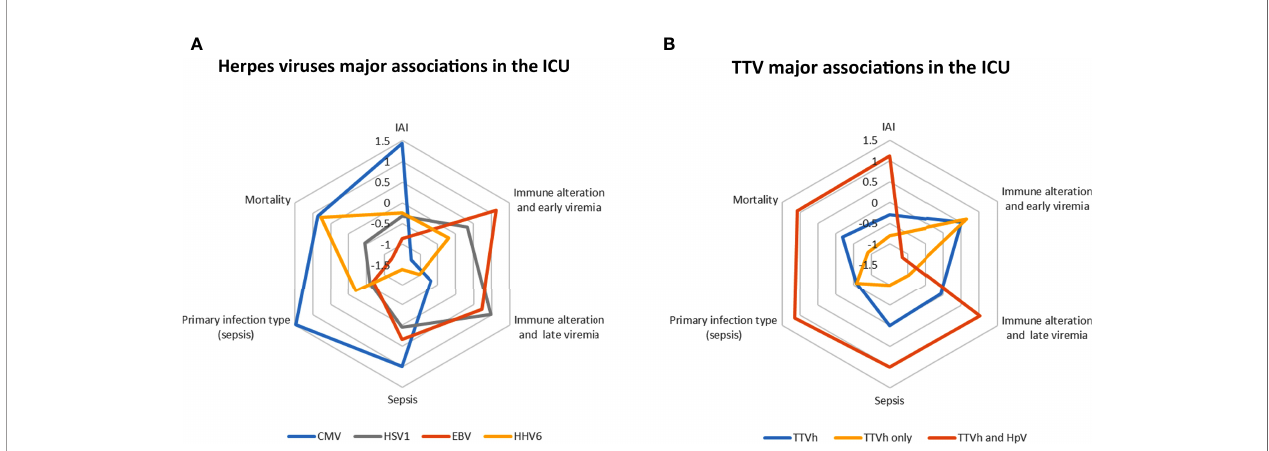
FIGURE 3 | A simpli fi ed view of CMV, HSV1, EBV, HHV6, and TTV major associations in the ICU. (A) Comparative view of herpesviruses major associations in the ICU with the presence of CMV, HSV1, EBV, and HHV6 viruses over the month de fi ned according to the LOD. (B) Comparative view of TTV major associations in the ICU with the presence of viruses over the fi rst week categorized as high viral titre (TTVh), co-reactivation (TTV and HpV), or exclusive detection (TTVh only). IAI index (Intensive Care Unit-acquired infection): ratio of the percentages of patients with a detected viraemia according to the presence versus the absence of IAI during the month (source: Table 3 ). Immune alteration indexes: extent of the [ (A) fi rst week, (B) month] immune alteration associated with the presence of a virus during the week (early viraemia) and during the month (late viraemia) represented by the number of events of signi fi cantly modulated immunological and molecular markers (source: Figure 2 and Supplementary Figure S2 ). Sepsis index: ratio of the percentages of patients with a detected viraemia during the fi rst week with sepsis versus other conditions in the ICU (trauma and surgery and burns patients) (source: Table 4 ). Primary infection type index: ratio of the percentages of sepsis patients (without IAI during the month) with a detected viraemia during the month according to hospital acquired primary infection versus community acquired primary infection (source: Supplementary Table S4 ). Mortality index: ratio of the percentages of patients with a detected viraemia during the fi rst week according to death at 28 days versus no death at 28 days (source: Table 3 ). All index ratios were harmonized in centred and scaled variables to draw the radar